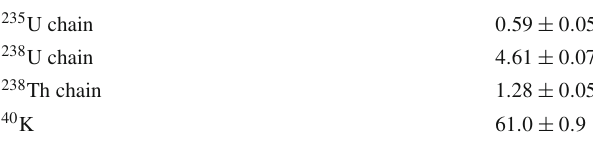
Table 2 Radioactive isotope activities in Bq/kg as used in the simula-